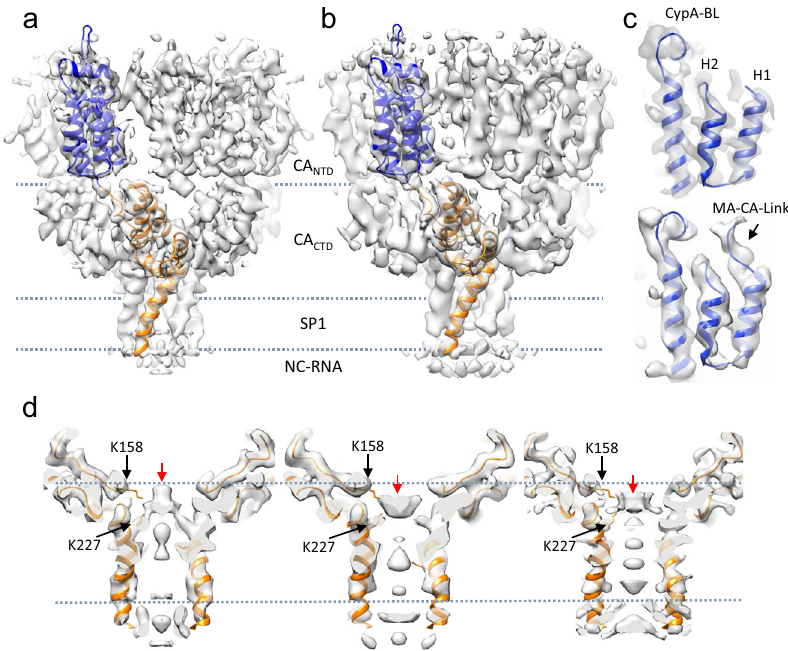
Fig. 2 Structures of immature GagT8I CA-SP1 by subtomogram averaging. a , b The density maps of immature Gag CA-SP1 from Gag Δ MA T8I assemblies ( a ) and GagT8I VLPs ( b ), overlaid with the re fi ned respective atomic models shown in blue (CA NTD ) and orange (CA CTD -SP1). Domain regions are labelled. c Enlarged views of CypA-binding loop (CypA-BL) and N-terminal MA-CA linker in Gag Δ MA T8I assemblies (top) and GagT8I VLPs (bottom). d Detailed views of the central densities within the six-helix bundle of Gag Δ MA T8I assemblies (left), GagT8I VLPs (middle) and Gag Δ MA T8I assemblies with 10 µ M IP6 (right). Black arrows point to the lysine residues from CA CTD , K158 and K227, forming two-rings to coordinate a central density (red arrows). Dashed lines mark the same height in both density maps.